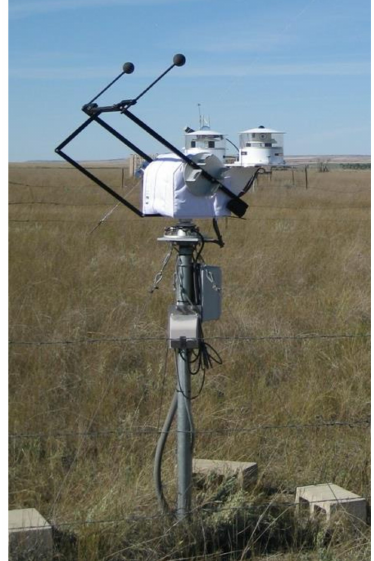
Figure 3. Example of pyranometer for measuring di ff use radiation. An accurate sun-tracker is installed to shield the pyranometer from direct solar beam. Photo is courtesy of surface radiation budget network (SURFRAD) US-FPK